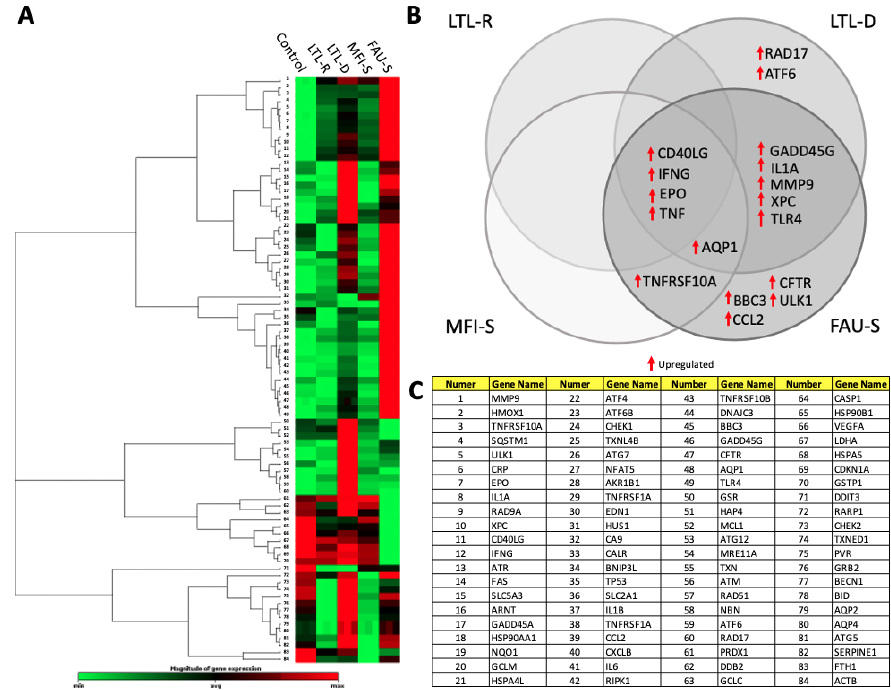
Figure 9. Gene expression profiles in IMR-90 cells after exposure to 50 µ g/mL of zeolites ( A ) Cluster- gram of gene expression exposed to 50 µ g/mL of LTL-R, LTL-D, MFI-S and FAU-S using PCR arrays. ( B ) Significantly altered gene expression with more than 2-fold change is shown in Venn diagrams organized by zeolite type. ( C ) Gene list of PCR array panel. Table 3. Gene expression of TNF related component in zeolite exposed lung fibroblast using qRT-PCR. TNF Related